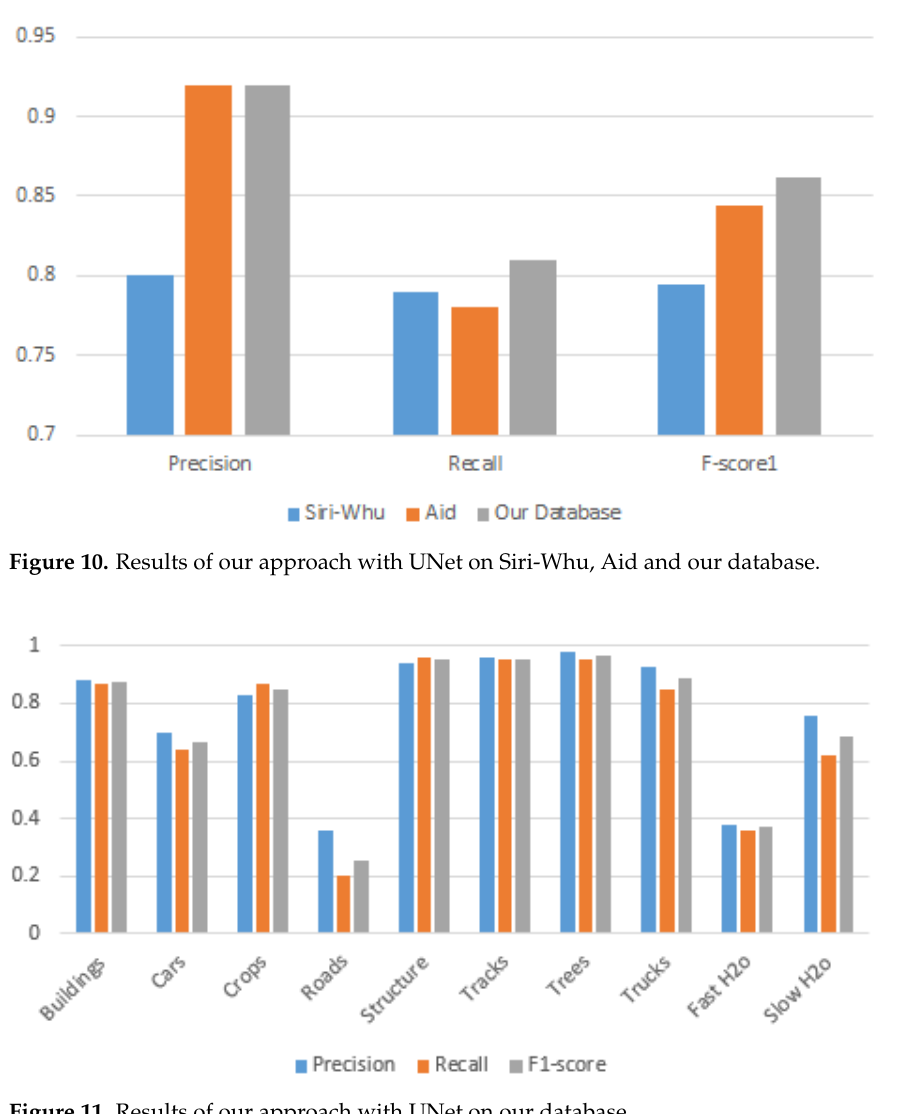
Figure 11. Results of our approach with UNet on our